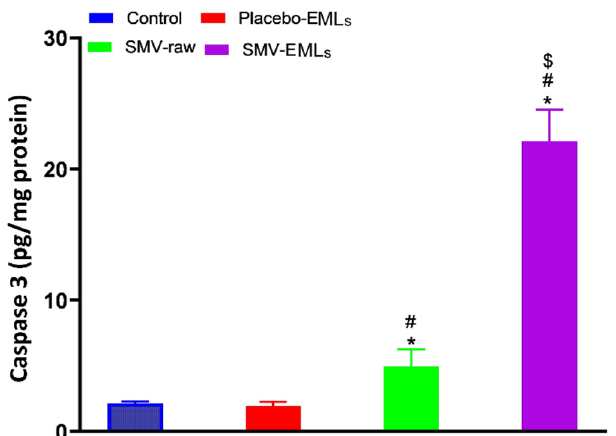
Figure 10. Modulation of Placebo-EMLs, SMV-raw, or optimized SMV-EMLs treatments on caspase-3 enzyme concentrations in MCF-7 cells. Values were normalized with respect to control untreated MCF-7 cells and are expressed as the percent variation of caspase 3. * Significantly di ff erent vs. Control ( p < 0.05); # Significantly di ff erent vs. Placebo-EMLs ( p < 0.05); $ Significantly di ff erent vs. SMV-raw ( p <